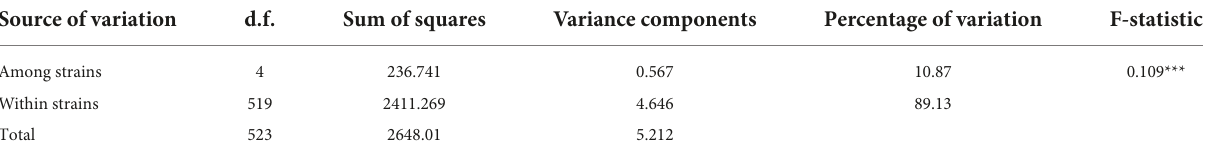
TABLE 3 Analysis of molecular variance (AMOVA) of strains.